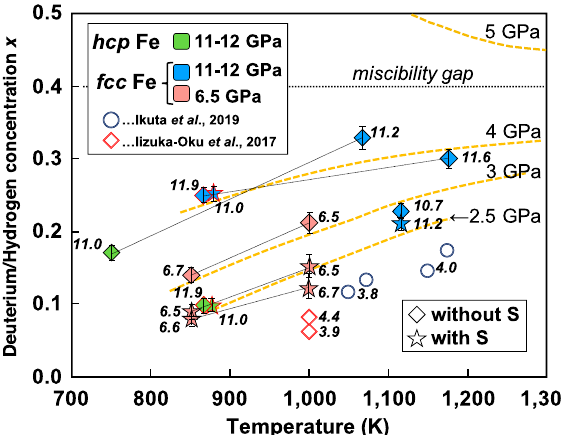
Figure 3. Plots of deuterium/hydrogen concentration ( x ) versus T for hcp and fcc Fe phases. Pressure values in GPa are shown on each plot. Symbols and colors are the same as those in Fig. 1. Data from previous studies (blue circles from Ikuta et al . 16 and red diamonds from Iizuka-Oku et al . 17 ) are also plotted. Dotted yellow lines show P– x –T relations in the Fe–H system of Hiroi et al . 34 . The miscibility gap they reported is shown at x ~ 0.4 as a dotted horizontal